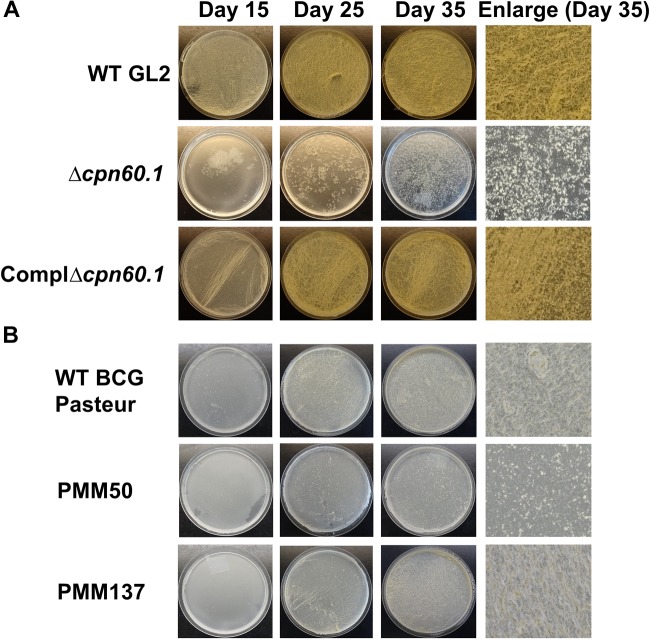
The Δcpn60.1 biofilm defect under standard Sauton’s medium partially resulted from PDIM/PGL alteration. (A) BCG GL2 strains were grown as biofilms in 6% glycerol Sauton’s medium for indicated time points. The ComplΔcpn60.1 is the complemented strain expressing Cpn60.1. (B) Biofilms of BCG Pasteur strains were grown as in (A). PMM50 and PMM137 are PDIM−/PGL− and PDIM−/PGL+, respectively. The experiments were performed at least three times. Representative biofilm pictures are shown.